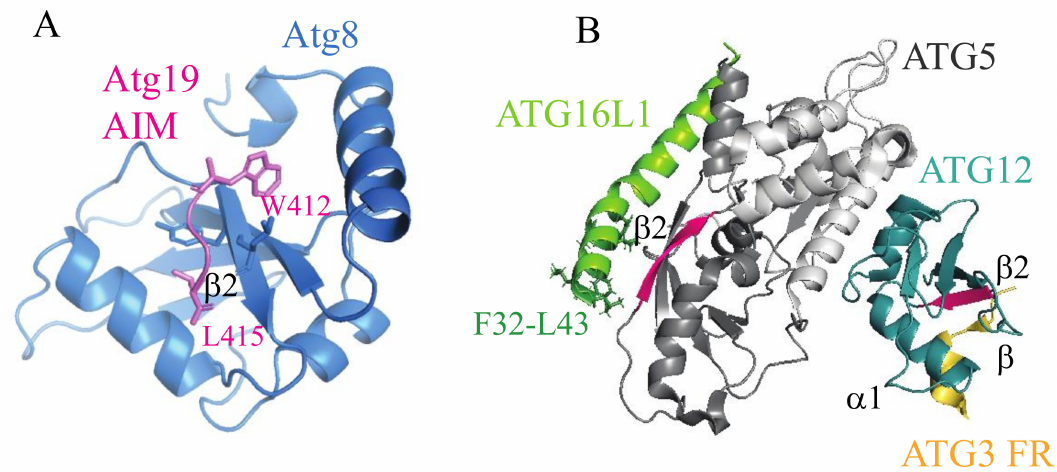
Figure 2. Binding of the autophagy related 8 (Atg8)-interacting motif (AIM) / microtubule associated protein 1 light chain 3 (LC3)-interacting region (LIR) sequences to the ubiquitin-like folds in the autophagy machinery. ( A ) The Atg8 ubiquitin-like (UBL) folds in a complex with the Atg19 AIM peptide (PDB ID: 2ZPN). Hydrophobic amino acid residues in the AIM motif (WEEL) are inserted into the two hydrophobic cavities (W and L site) on the flanking surface areas of the β 2 strand. The Atg19 AIM tetrapeptide and the Atg8 β 2 strand form an intermolecular β -sheet, a secondary structure found in all canonical AIM / LIR-Atg8 / LC3 / GABA type A receptor-associated protein (GABARAP) interactions. ( B ) The ATG3-ATG12–ATG5-ATG16N complex (PDB ID: 4NAW) in ribbon representation. When ATG3 binds to ATG12, the β 2 strand (pink) of ATG12 forms an intermolecular β sheet with the β strand (orange) of the AADM 157 tetrapeptide in the disordered region of ATG3 (ATG3 FR). The UBL-A domain (dark gray) on ATG5 possesses the β 2 strand (pink). It remains to be elucidated if the ATG5 β 2 forms an intermolecular β sheet with the β strand of the LIR motifs in autophagy receptors. Note that the ATG16L1 helical region spanning amino acid residues F32-L43 forms an amphipathic helix that inserts into a lipid bilayer [28,29], instead of binding to ATG5 that is seen in the crystal structure in the absence of membranes. FR, flexible